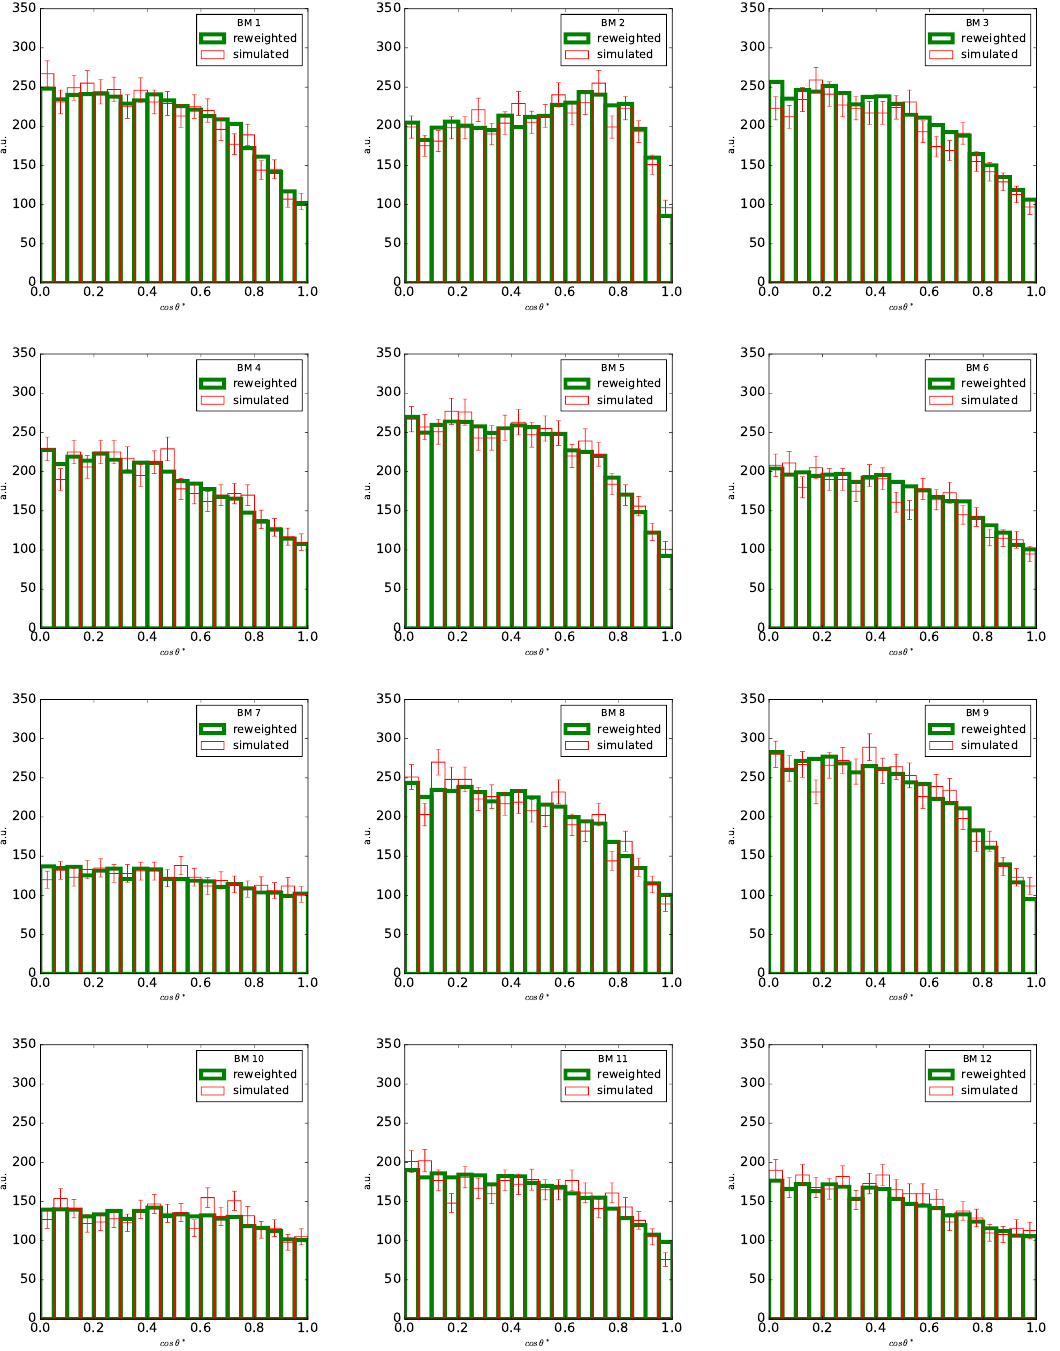
Figure 16 . The reconstructed cos θ ∗ after ATLAS-like selection. The histograms are normalized by signal efficiency times 100,000